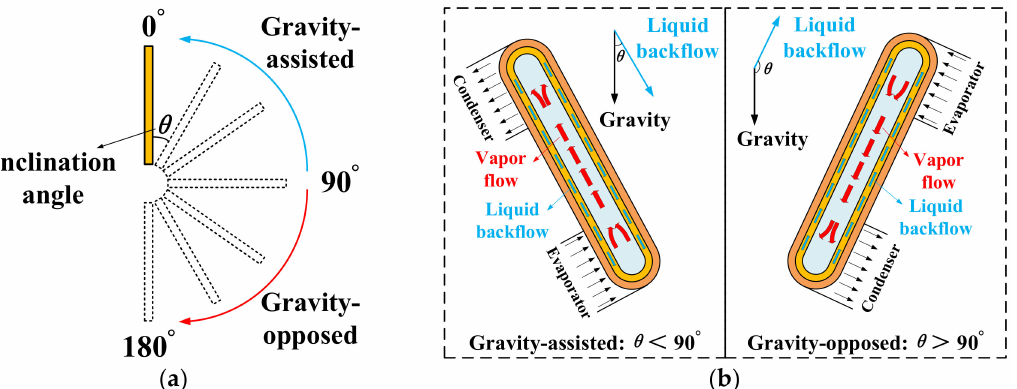
Figure 1. HP inclination angle effect. ( a ) Schematic of HP inclination angle. ( b ) Schematic of gravitational effect on the backflow of the interior working medium under the gravity-assisted case and gravity-opposed case.